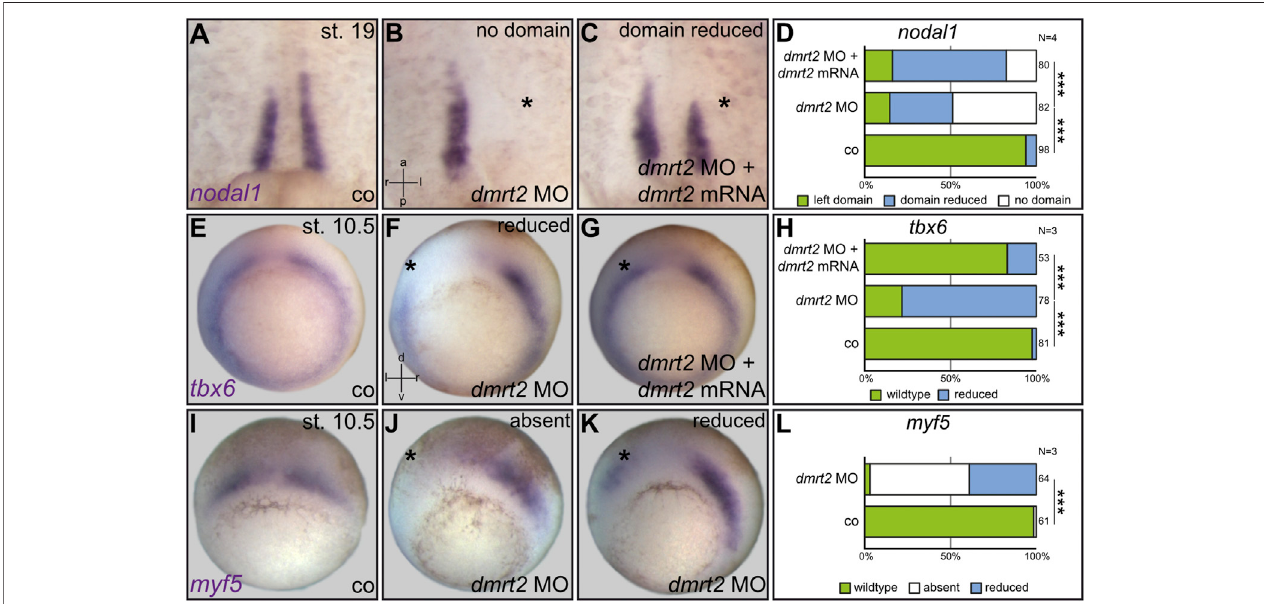
FIGURE 2 | Loss of nodal1 in sLRO cells by dmrt2 knockdown correlates with impaired expression of the somitic marker genes tbx6 and myf5 at gastrula stages. nodal1 mRNA was analyzed at stage (st.) 19 in untreated controls [co, (A) ], unilaterally injected dmrt2 MO morphants (B) or specimens that received a mix of dmrt2 MO and rescue dmrt2 mRNA (C) . nodal1 expression was lost or reduced in dmrt2 morphants (B,D) . Statistical analysis shows that nodal1 was very highly signi fi cantly rescued (C,D) . Early gastrula embryos were stained for tbx6 and myf5 (E – L) . Controls showed horseshoe-like tbx6 expression, omitting the Spemann organizer (E) . tbx6 signals were reduced by dmrt2 MO on the injected side (F,H) , which by statistics was signi fi cantly rescued upon co-injection of dmrt2 mRNA (G,H) . The angel wing-like expression pattern of myf5 (I) was lost (J,L) or reduced in dmrt2 morphants as well (J,L) . The asterisk mark the injected side. Numbers in (D,H,L)